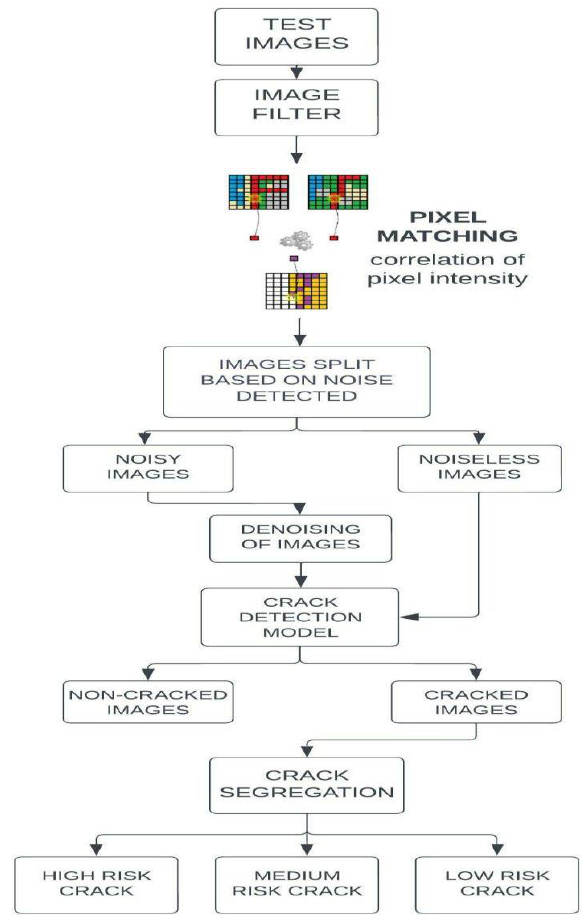
Figure 2. Flowchart of the proposed algorithm.